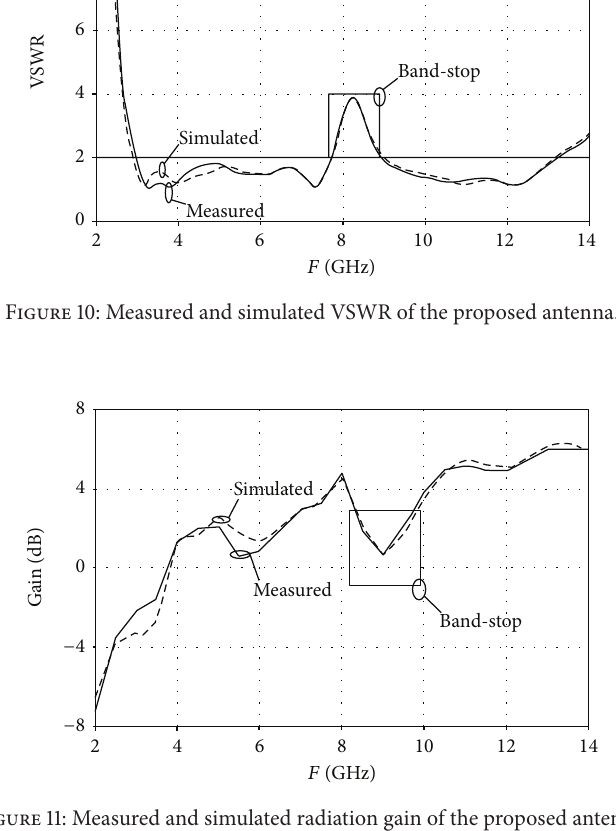
Figure 11: Measured and simulated radiation gain of the proposed antenna.